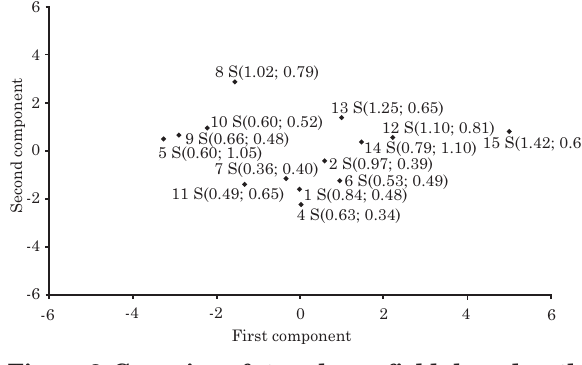
Figure 3. Grouping of strawberry fields based on the application of PCA for soil chemical variables in the 0-0.20 m layer. The S values in parentheses represent the standard deviation for the first and second components,